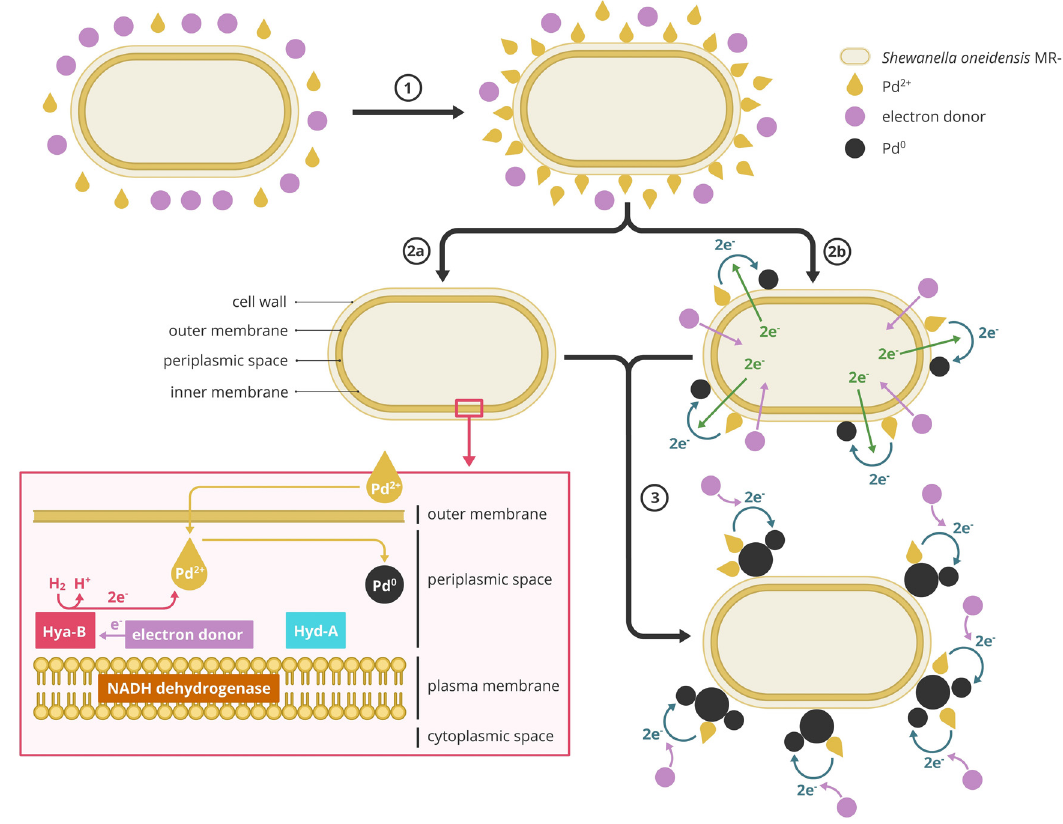
Figure 1: Production mechanism of bio - Pd NPs inside and outside the microorganisms: ( 1 ) Adsorption of Pd 2 + on the cell wall, ( 2a ) conversion of Pd 2 + to Pd 0 inside the cell, ( 2b ) on the cell wall, and ( 3 ) autocatalytic conversion of Pd 2 + to Pd 0 outside the cell. The fi gure was inspired by Deplanche et al. [ 27 ] , Ng et al. [ 52 ] , and Yang et al. [ 26 ]